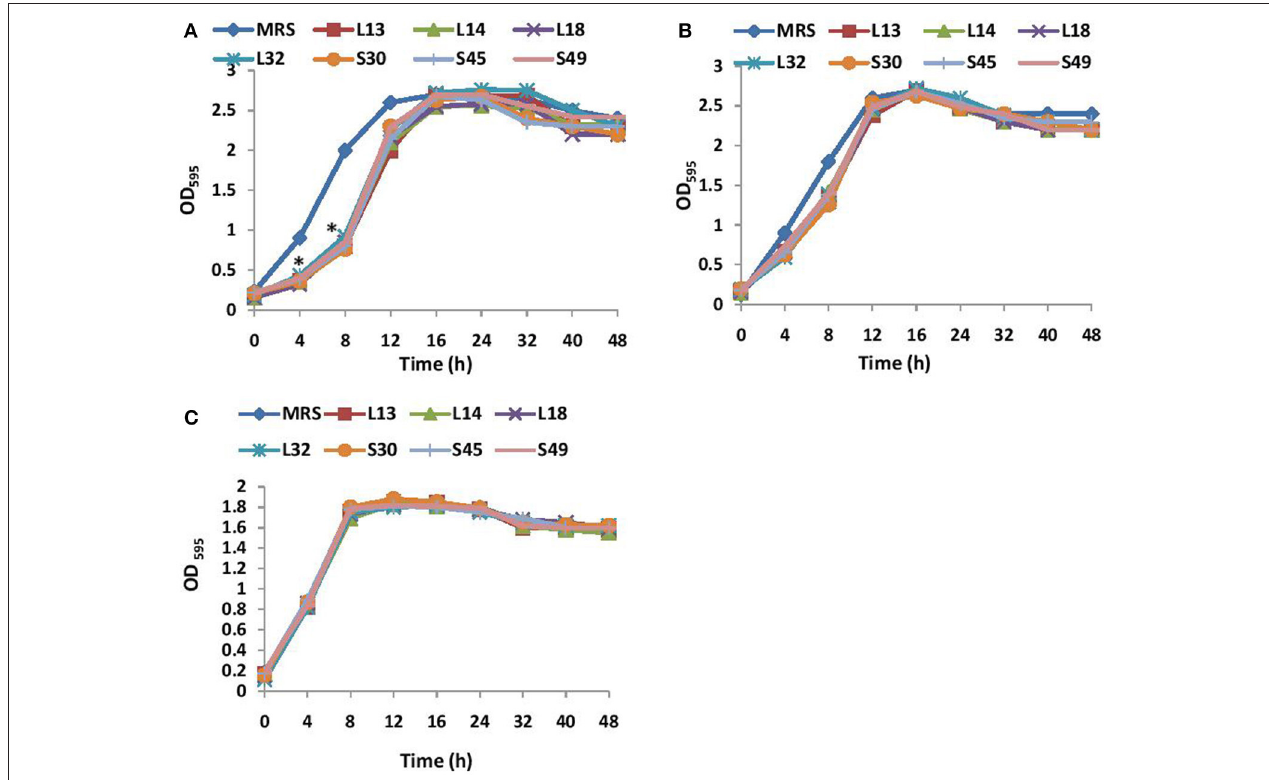
FIGURE 1 | (A) Growth curves of V. cholera in BHI supplemented with non-neutralized CS and (B) pH neutralized CS of lactobacilli strains. (C) Growth curve of V. parahaemolyticus in BHI supplemented with non-neutralized CS of seven different Lactobacilli strains. *Significance ( p < 0.001) was measured by using an unpaired Student’s t -test relative to the growth in BHI supplemented with MRS at 45 mg/ml.